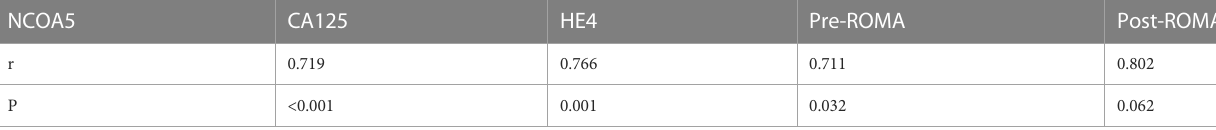
TABLE 3 Correlation analysis between NCOA5 expression and other tumor markers.